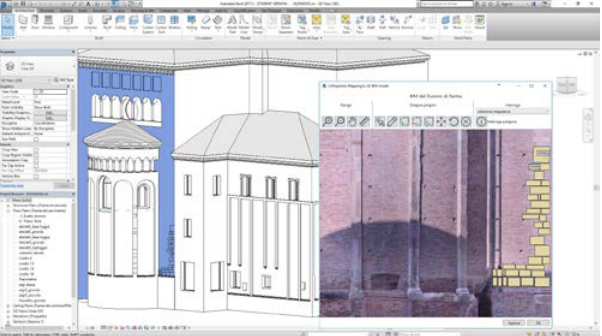
Figure 8_Example of mapping starting from